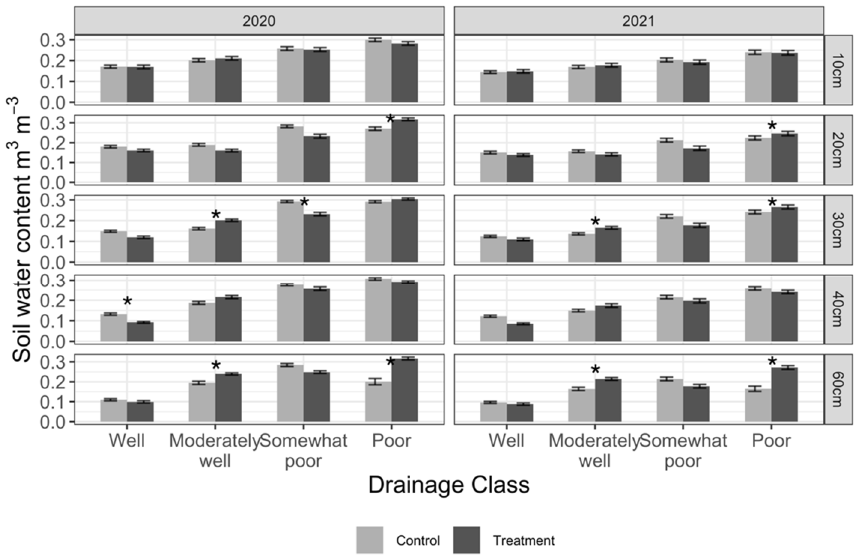
Figure 1. Three-way interaction between treatment, drainage class, and sensor depth for the two years of SWC models. Asterisks indicate a significant difference ( p < 0.05) between the control and treatment within each drainage and treatment combination. Error bars indicate the standard error. The sensor depth in centimeters in shown on the right y-axis.